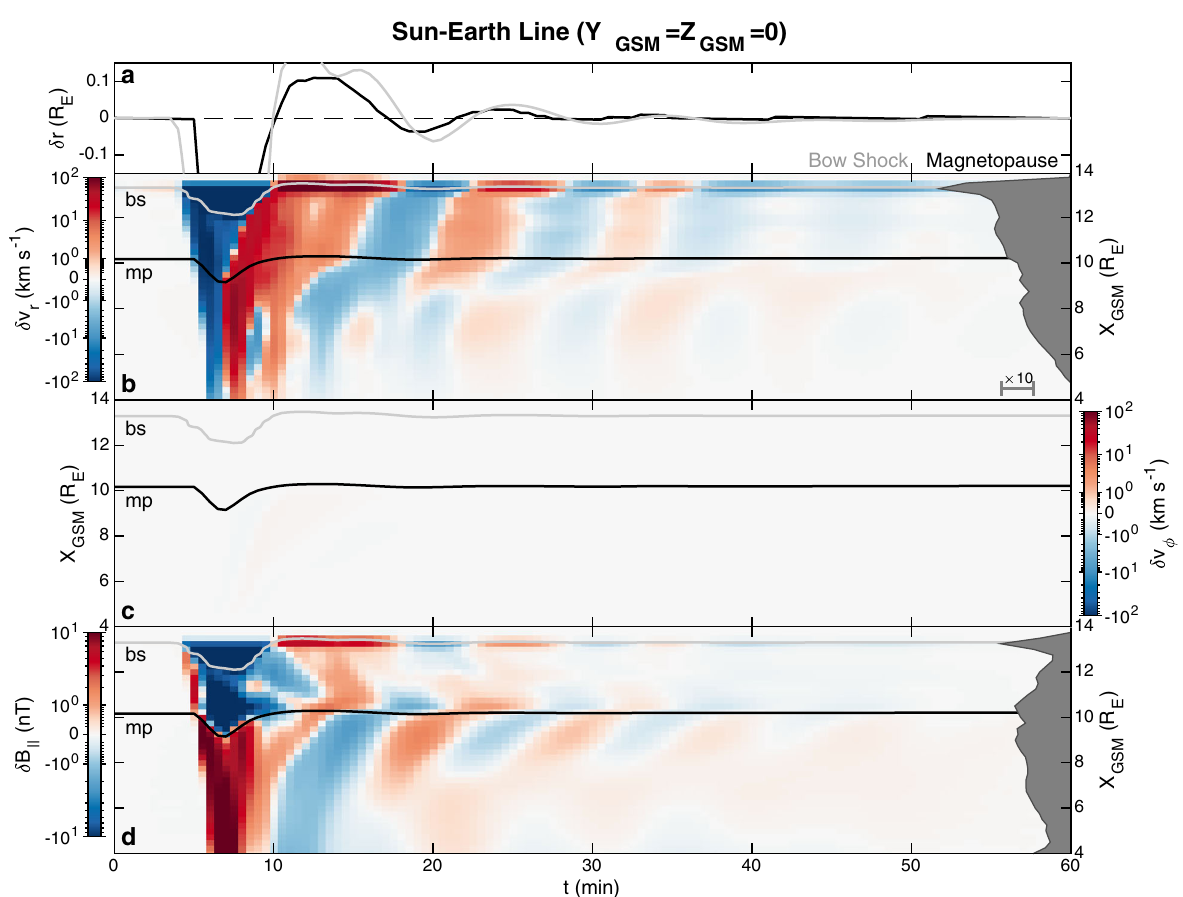
Fig. 4 Un fi ltered perturbations in MHD simulation along the Sun – Earth line. Panel a shows motion of the bow shock (grey) and magnetopause (black) about equilibrium. Subsequent panels show perturbations in the b radial velocity, c azimuthal velocity and d compressional magnetic fi eld components (note the bi-symmetric log scale). Median absolute perturbations by distance are displayed to the right as the dark grey areas on a logarithmic scale. The bow shock (light grey) and magnetopause (black) locations are also